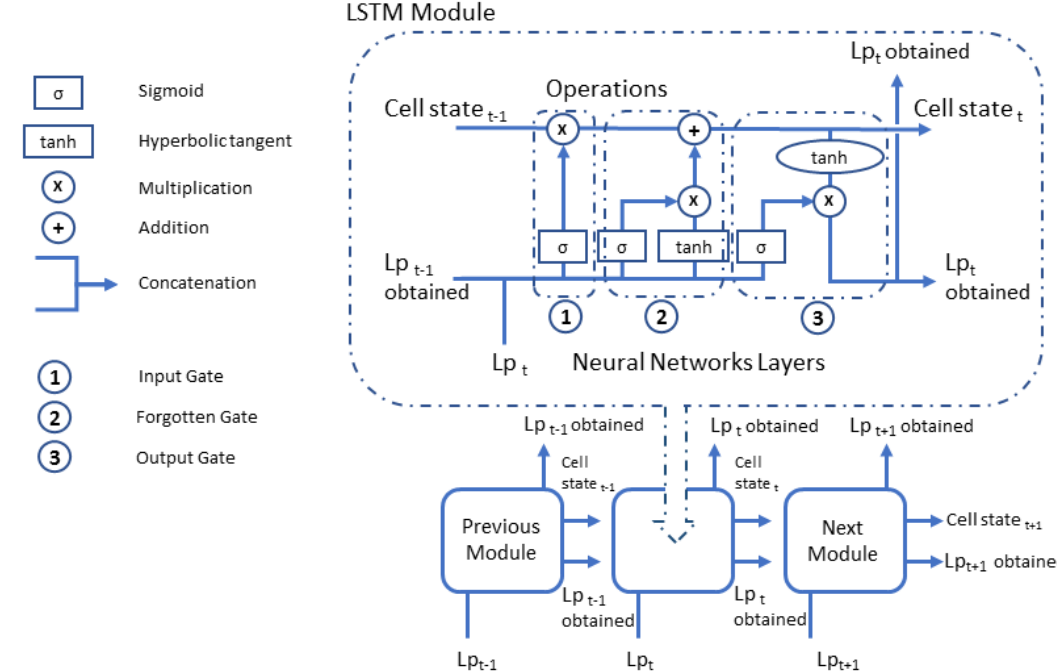
Figure 1. General scheme of an Long Short-Term Memory neural networks (LSTM) for L p . The interaction between LSTM modules can be observed, as well as the three types of gates that make up an LSTM